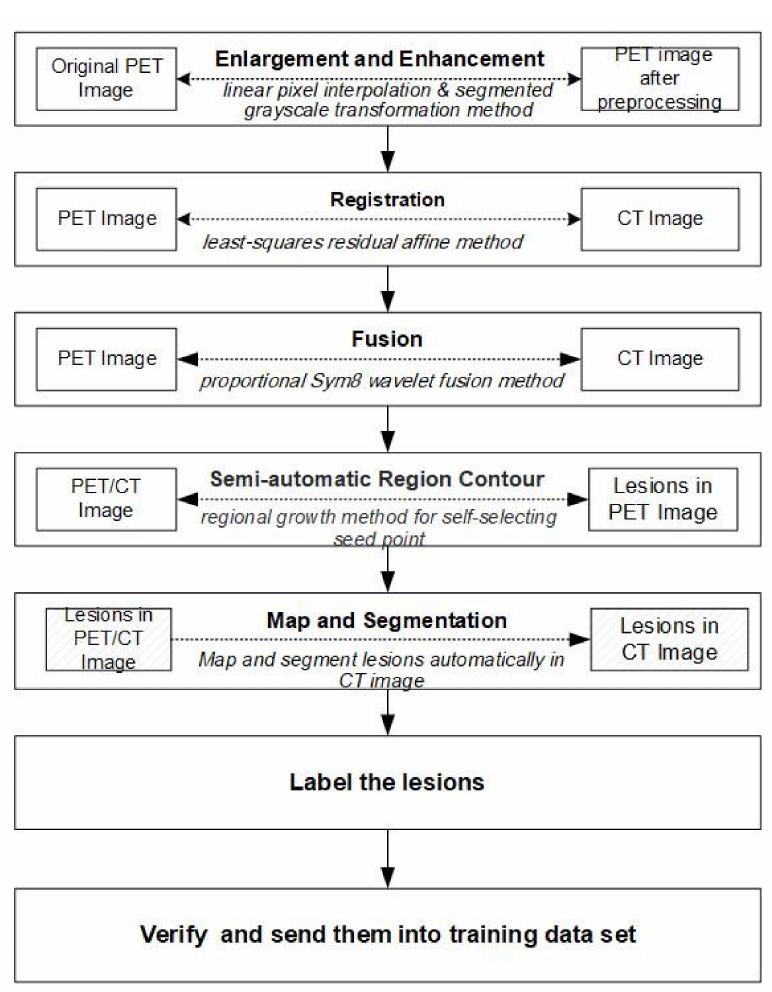
Figure 1. Flowchart of the technical